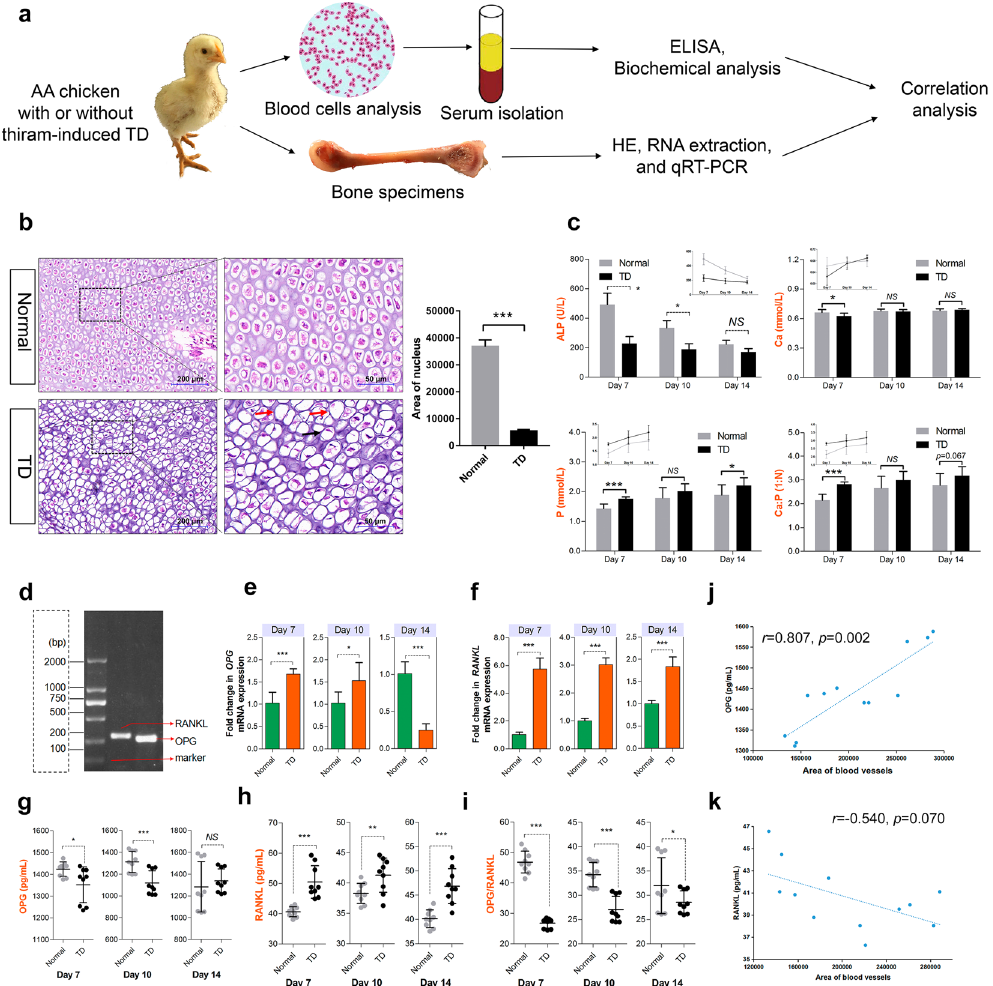
Figure 5. Growth plate vascularization is essential for chondrocyte growth and differentiation to promote bone mineralization. ( a ) A schematic diagram illustrating the experimental design. Serum and bone specimens were collected from normal and TD chickens at 7, 10 and 14 days old, respectively. ( b ) Representative images of tibia sections stained with H&E from lower hypertrophic chondrocyte zone of the proximal tibia growth plate of normal and TD chickens. Higher magnification is shown on the right. Black arrow indicates pyknosis. Red arrows indicate karyolysis. ( c ) Serum alkaline phosphatase (ALP), calcium (Ca) and phosphorus (P) levels in normal and TD chickens. Data represent means ± s.e.m. (n = 3 chickens from three independent experiments). * p < 0.05, *** p < 0.001, two-tailed unpaired t -test. NS, not significant. ( d ) Gel electrophoresis diagram of the OPG and RANKL genes. ( e , f ) qRT-PCR analysis of OPG and RANKL expression (normalized to GAPDH) in proximal TGPs sorted from normal and TD chickens at 7, 10 and 14 days, respectively. Data represent means ± s.e.m. (n = 3 biological replicates). ** p < 0.01, *** p < 0.001, two-tailed unpaired t -test. NS, not significant. ( g–i ) OPG and RANKL concentrations assessed by serum ELISAs and the OPG/RANKL ratio were also determined. (n = 9 in each group from three independent experiments, 3 technical replicates per experiment). Data represent means ± s.d. ** p < 0.01, two-tailed unpaired t -test. NS, not significant. ( j , k ) Correlation analysis between serum OPG level (j, n = 9), serum RANKL level (k, n = 9) and area of blood vessels in the hypertrophic chondrocyte zone of proximal tibia, respectively, were determined by Spearman tests. (n = 6, 3 sample replicates and 2 two isolated statistical groups (3 different microscopic fields were used as an